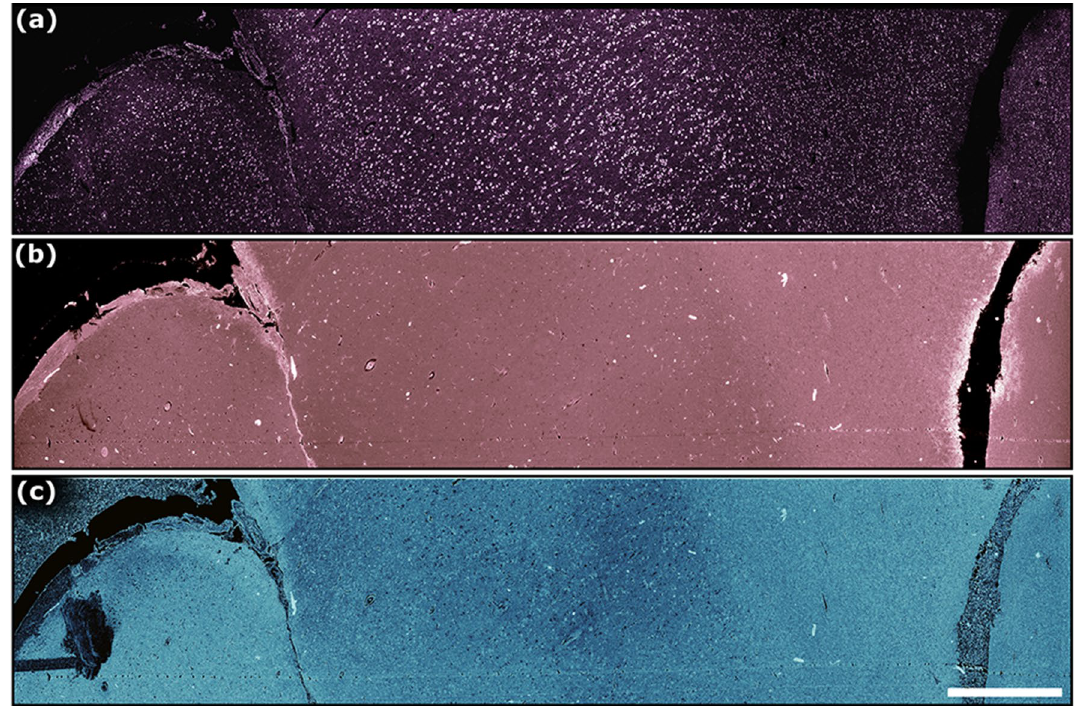
Figure 3. Comparison of the three different contrasts (non-radiative absorption, radiative absorption, and scattering) provided by the TA-PARS system, in a thin section of preserved human brain tissues. ( a ) 266 nm non-radiative absorption contrast. ( b ) 266 nm radiative absorption contrast. ( c ) 405 nm scattering contrast. Scale Bar: 1